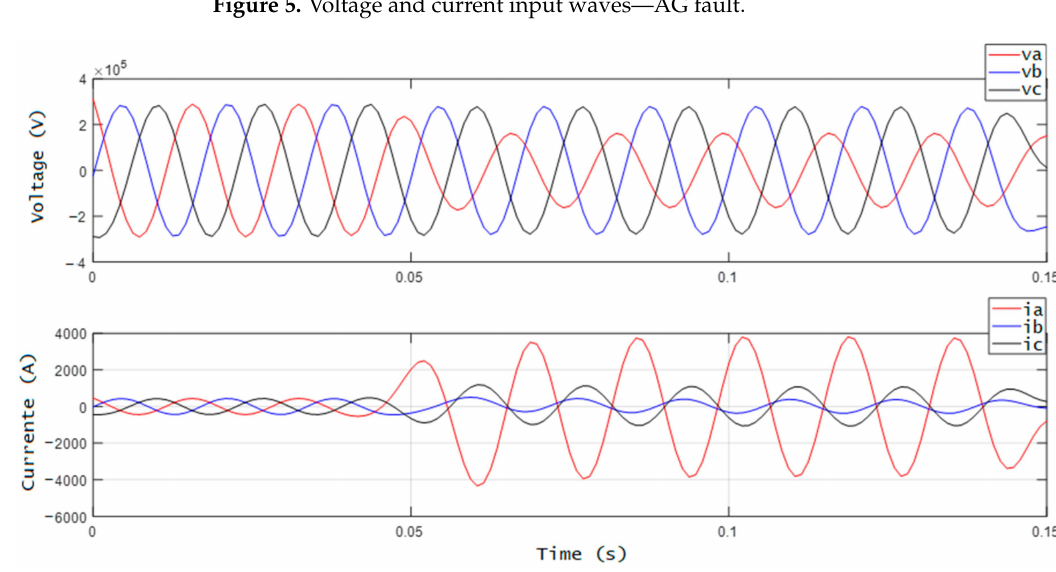
Figure 5. Voltage and current input waves—AG fault.